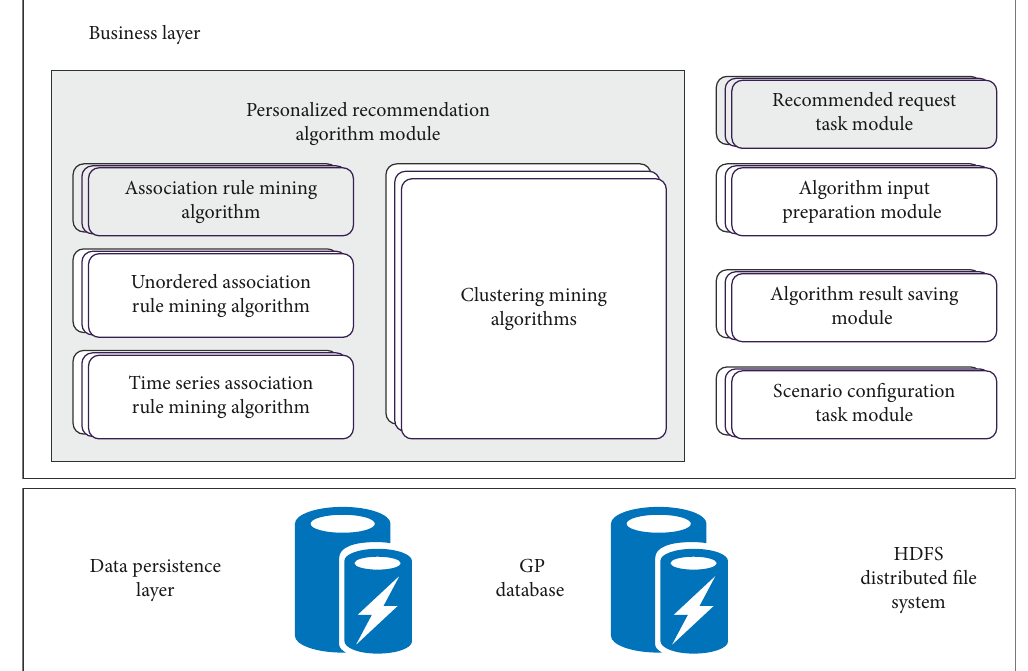
Figure 3: Structure diagram of the system architecture.